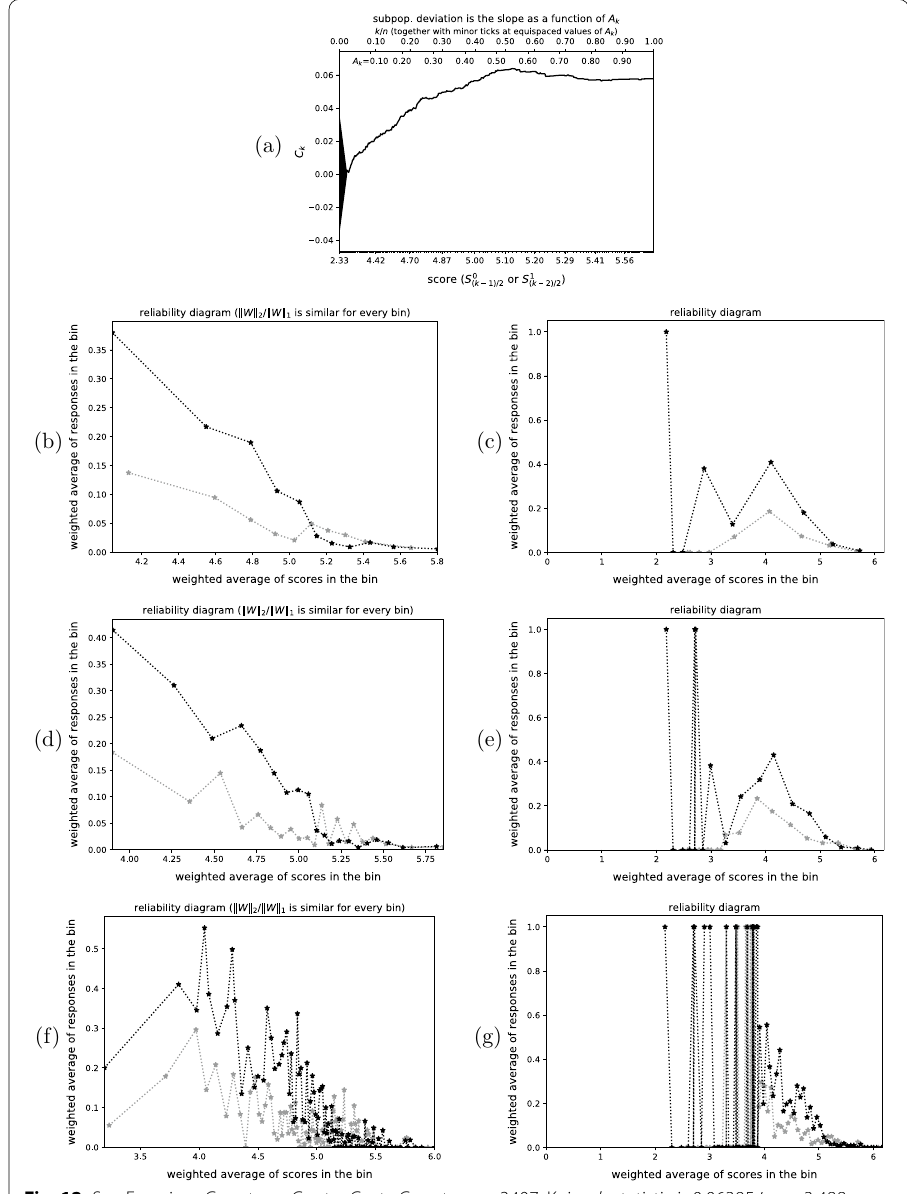
Fig. 12 San Francisco County vs. Contra Costa County; n = 3407; Kuiper’s statistic is 0.06395 /σ = 3.488 , Kolmogorov’s and Smirnov’s is 0.06395 /σ = 3.488 ; only the cumulative graph ( a ) fully captures the relatively small deviation for the very lowest scores, and having even just 100 bins in a reliability diagram ( f and g ) already produces far too much noise for most scores. The metrics of Kuiper and of Kolmogorov and Smirnov report statistically significant deviation between the